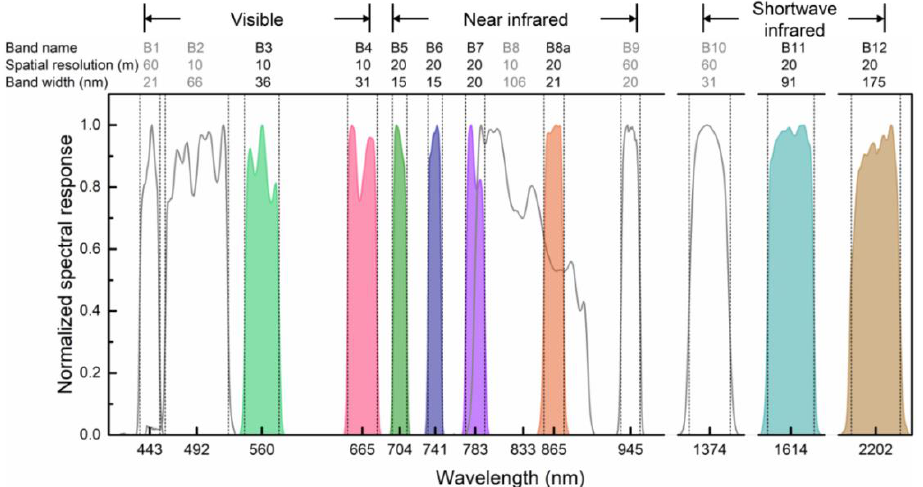
Figure 2. The normalized spectral response of Sentinel-2A multi-spectral instrument (MSI) bands. These bands cover the visible, near-infrared, and shortwave-infrared spectral domains. The top three rows show the name, spatial resolution, and width of each band, respectively. The filled area indicates